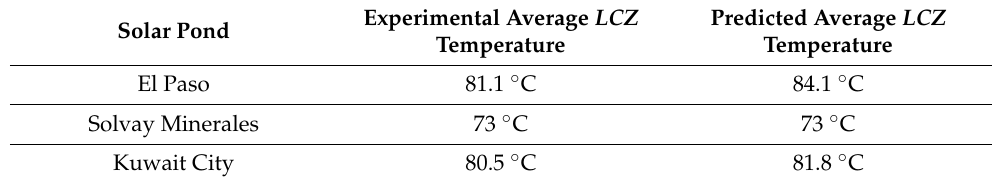
Table 2. Comparison between experimental and predicted results of solar